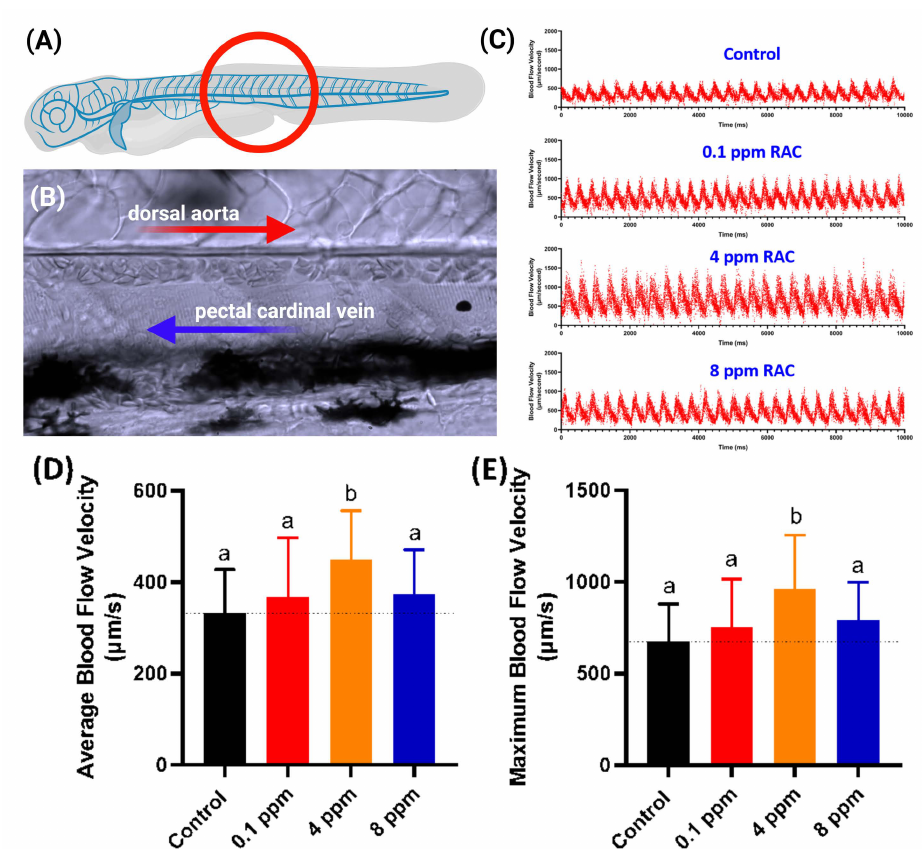
Figure 5. Evaluation of blood flow velocity in zebrafish larvae after exposed to RAC. ( A ) Schematic diagram showing the position for image capture to calculate blood flow velocity. ( B ) Magnification of red circle in ( A ) to show the position of dorsal aorta and post cardinal vein. ( C ) The time chronology of blood flow rate monitoring in the dorsal aorta of zebrafish embryos. ( D ) Average and ( E ) maximal blood flow velocity in the dorsal aorta of zebrafish larvae aged at 72-h post fertilization (hpf) after 24 h incubations in RAC from 48 hpf onwards. The data are shown as the means ± SD and were analyzed by one-way ANOVA test followed with Fisher’s LSD test. Different letters a and b above columns indicate significant statistical differences with p < 0.05 ( n = 21 for control, n = 20 for all RAC groups). Black bar: control, red bar: RAC 0.1 ppm, orange bar: RAC 4 ppm, and blue bar: RAC 8